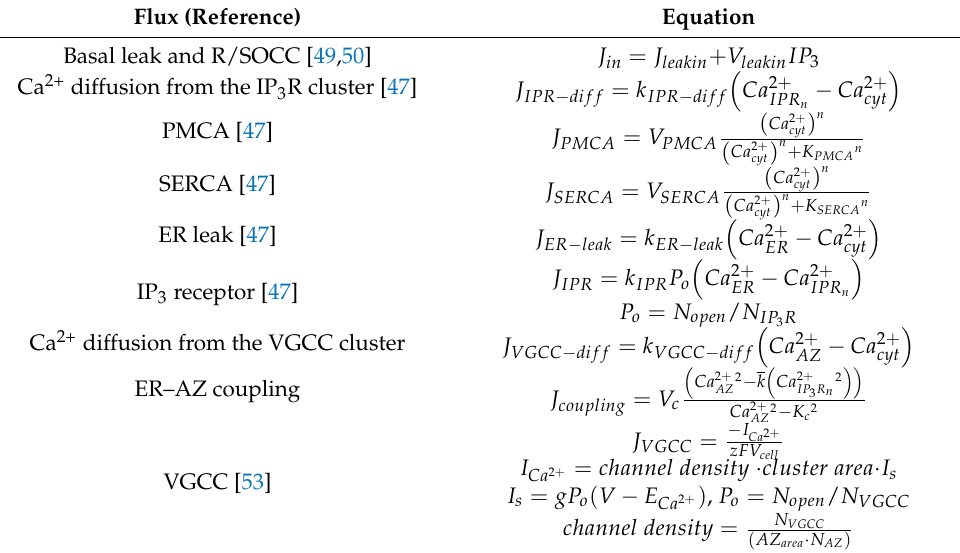
Table 1. Ca 2+ fluxes in the model.